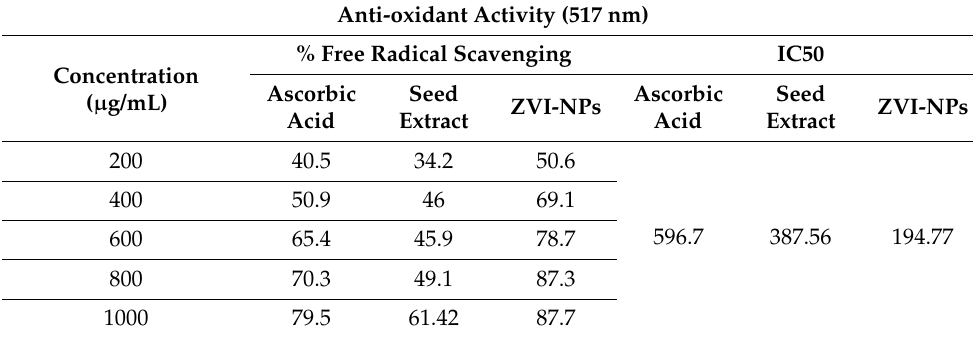
Table 5. Percentage free radical scavenging activity and calculated IC50 values of standard (ascorbic acid), seed extract of Nigella sativa, and